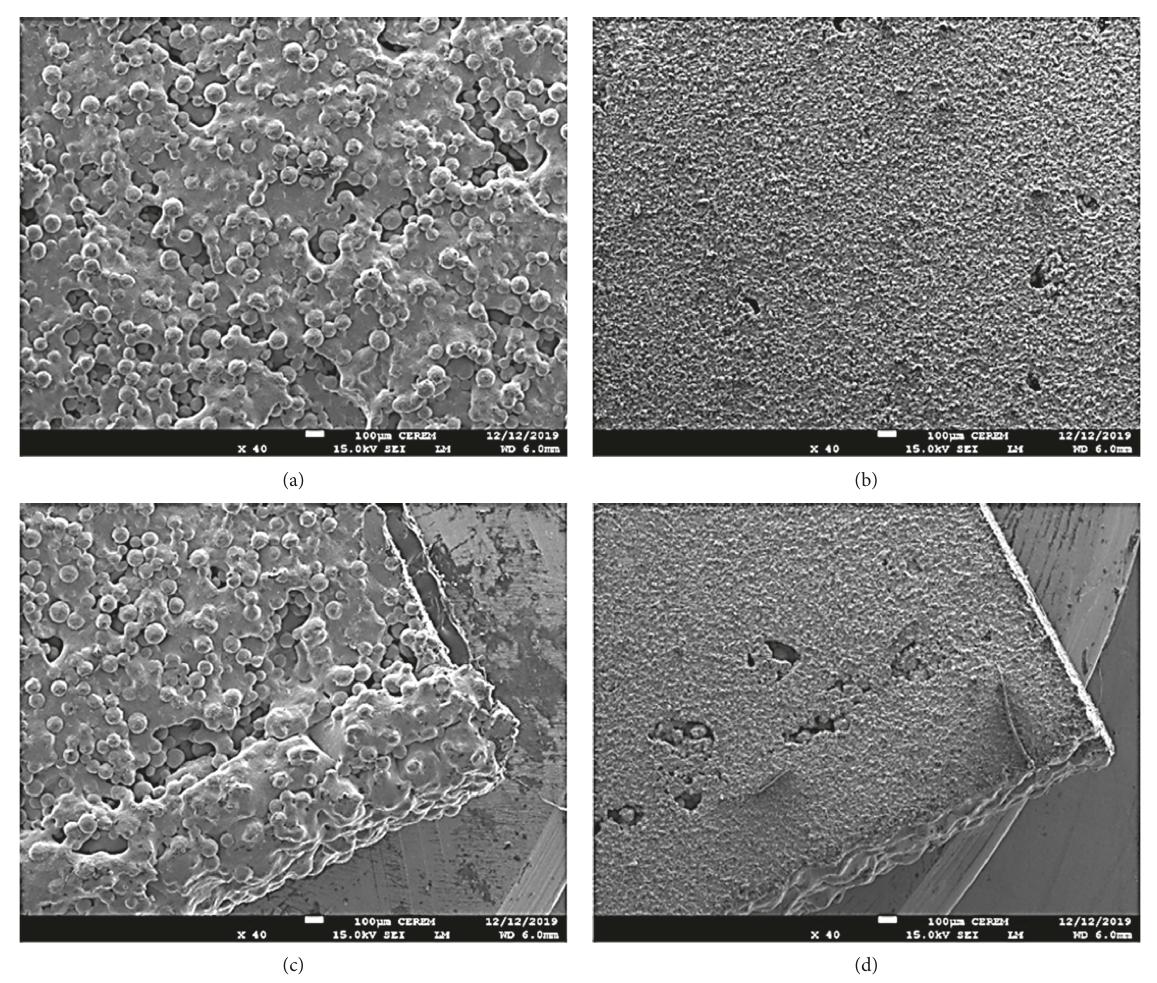
Figure 6: Topography of the supported surface after removing the support (a) manually, (b) using wire EDM, (c) edge of the down face after manual removal, and (d) edge of the down face after wire EDM